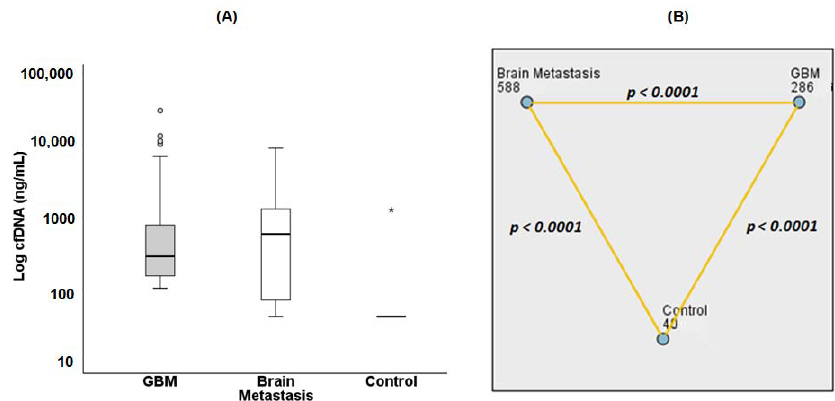
Figure 1. Median serum levels of circulating cell-free DNA (cfDNA) in the study groups. ( A ) Box plot graph of cfDNA levels in patients with glioblastoma (GBM) ( n = 122, median = 286 ng/mL), brain metastasis ( n = 55; median = 588 ng/mL) from adenocarcinoma stage IV (breast n = 19; lung n = 19; pancreas n = 2; colon n = 11; prostate n = 4) before intranasally administrated perillyl alcohol (ITN-POH) therapy compared with healthy control subjects ( n = 130, median = 40 ng/mL). ( B ) SPSS statistical package graphics output of median cfDNA pairwise comparisons of groups including the outliers, with respective significant differences (* p < 0.0001).